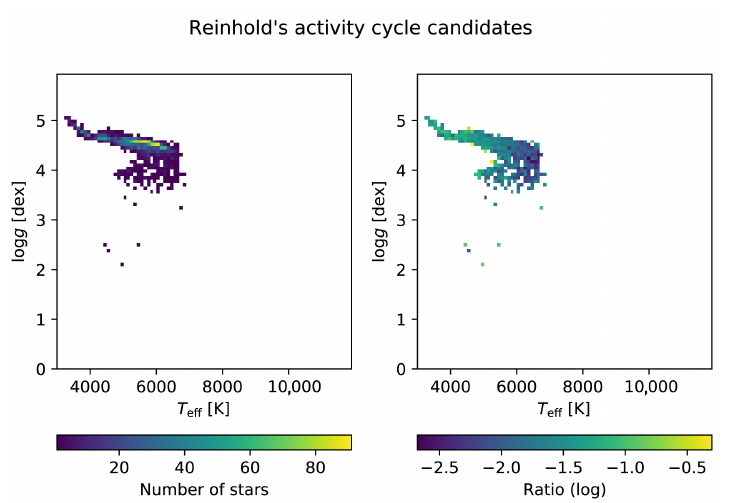
Figure 15. The left panel is the same as the middle panel of Figure 14, and the right panel is the same as the right panel of Figure 14 but using Reinhold et al. [29] cycle candidates.